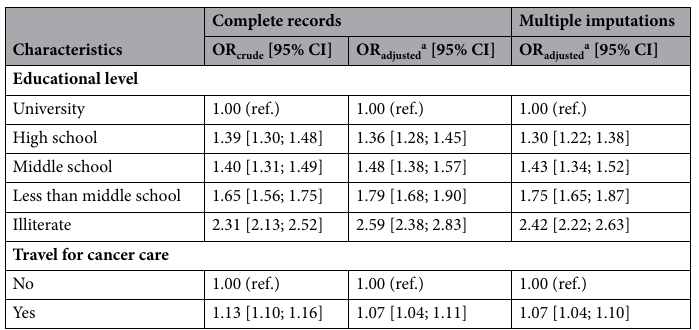
Table 2. Crude and adjusted odds ratio (OR) for advanced female breast cancer by educational level and travel burden. a Adjusted by all variables included in the table and also by age at diagnosis, histologic type, and year of